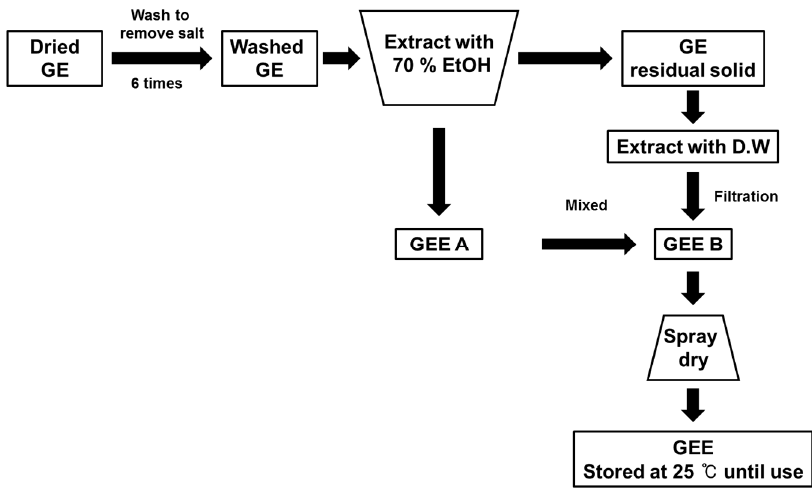
Figure 2. Preparation procedure for GEE [10].